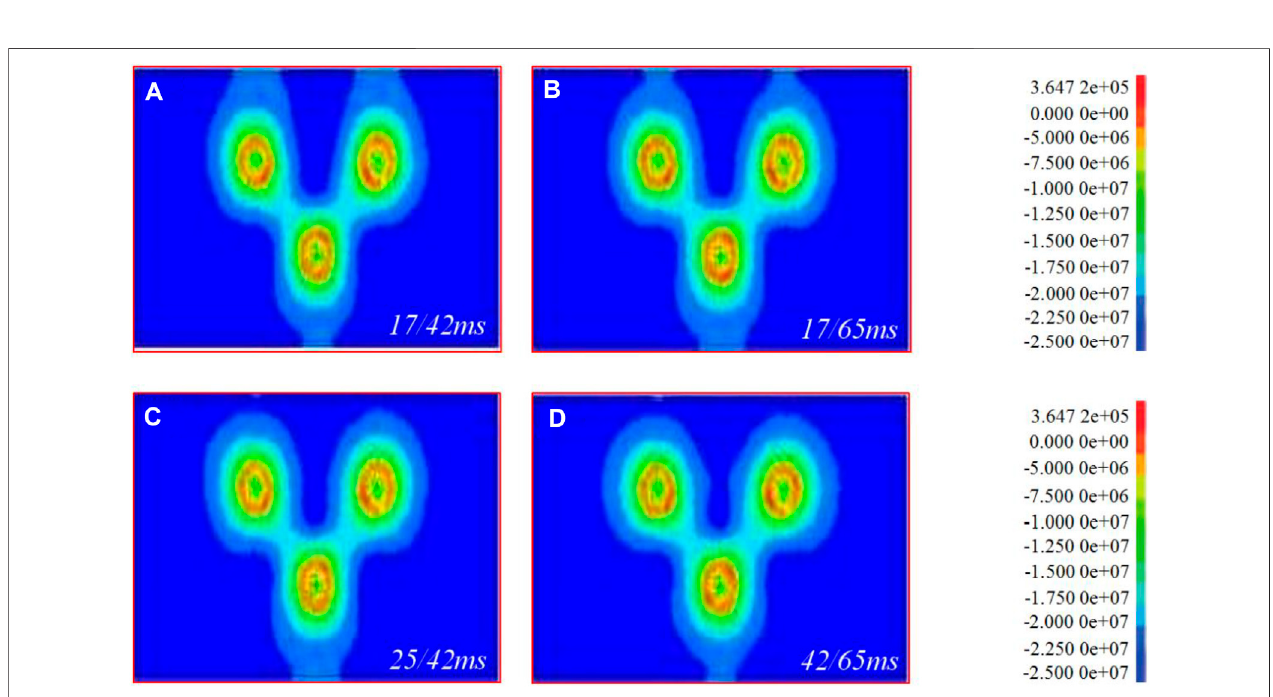
FIGURE 7 | 7 × 3.5 model 200 ms equivalent stress superposition. (A – D) are the superposition of equivalent stresses of 17/42 ms, 17/65 ms, 25/42 ms and 42/ 65 ms, respectively.